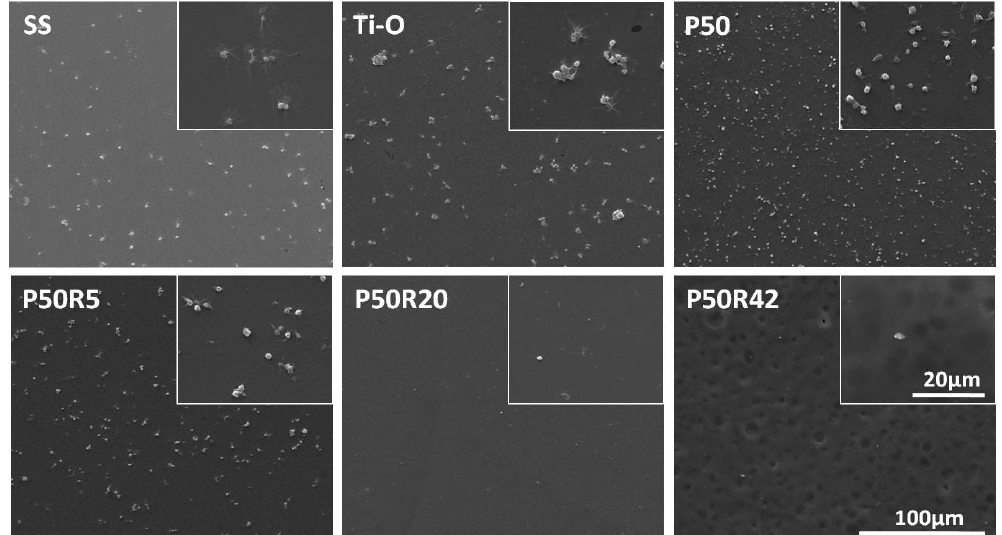
Figure 4. Morphology of adherent platelets on SS, Ti–O, P50, P50R5, P50R20, and P50R42 after 45 min of incubation in platelet-rich plasma (PRP) observed by SEM.